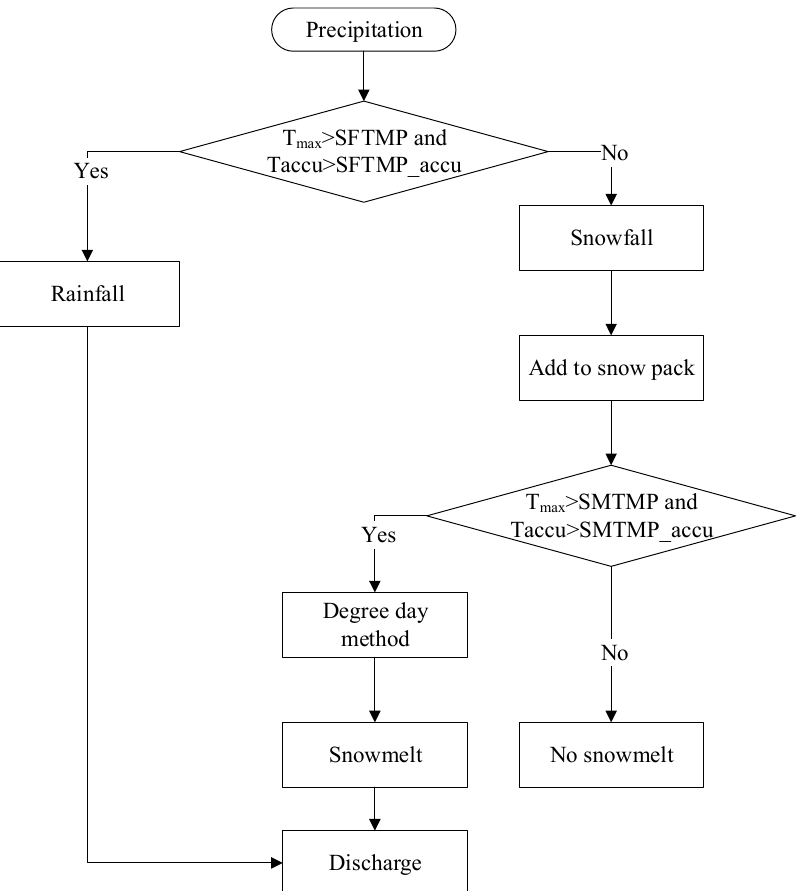
Figure 4. Framework of the modified degree-day factor method. T max means daily maximum temperature, SFTMP means snowfall temperature, SFTMP_accu means snowfall accumulated temperature, Taccu means daily accumulated temperature, SMTMP means snow melt base temperature, SMTMP_accu means snow melt base accumulated temperature.